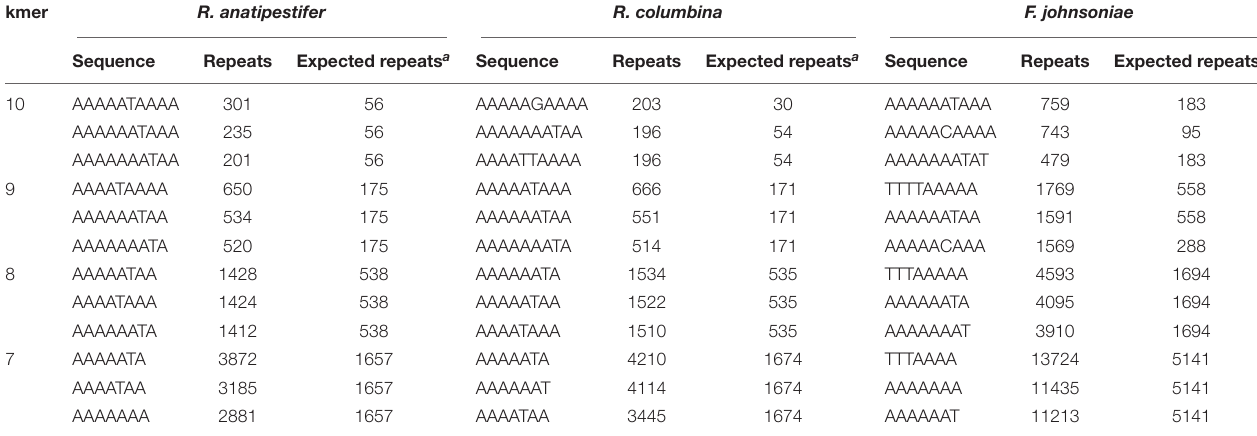
TABLE 3 | Analysis of putative DUSs or USSs in R. anatipestifer , R. columbina and F. johnsoniae. kmer